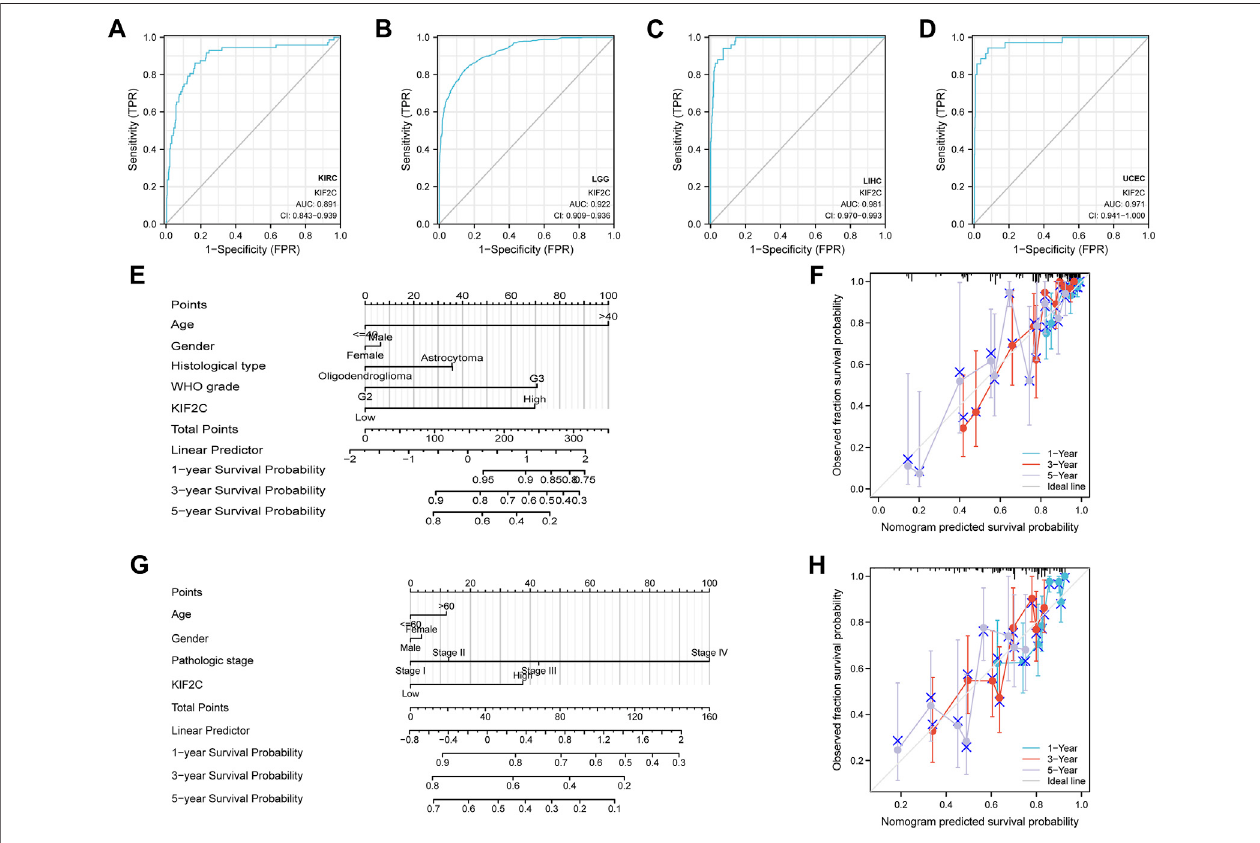
FIGURE 13 | Prediction evaluation and construction of nomograms (A – D) ROC analysis of KIRC, LGG, LIHC, and UCEC by KIF2C. (E) Construction of nomograms for LGG (F) Calibration curve validation of LGG. (G) Nomogram construction for LIHC. (H) Calibration curve validation of